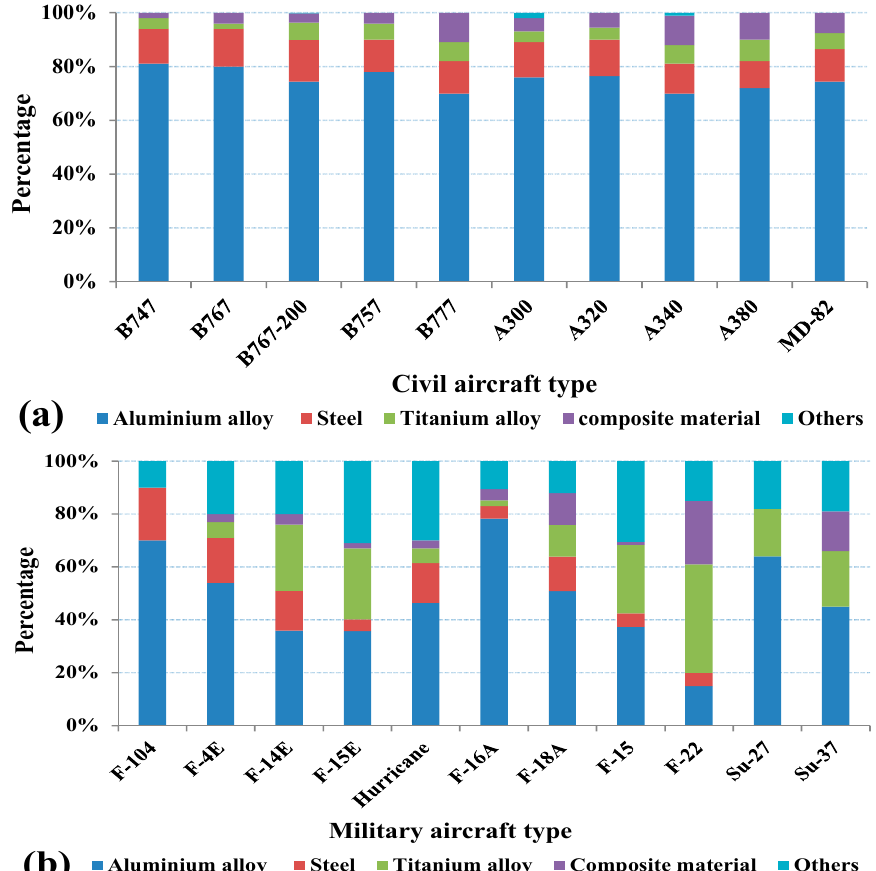
Figure 2. Ratio of materials used in Aircrafts: ( a ) civil ( b ) military [9].